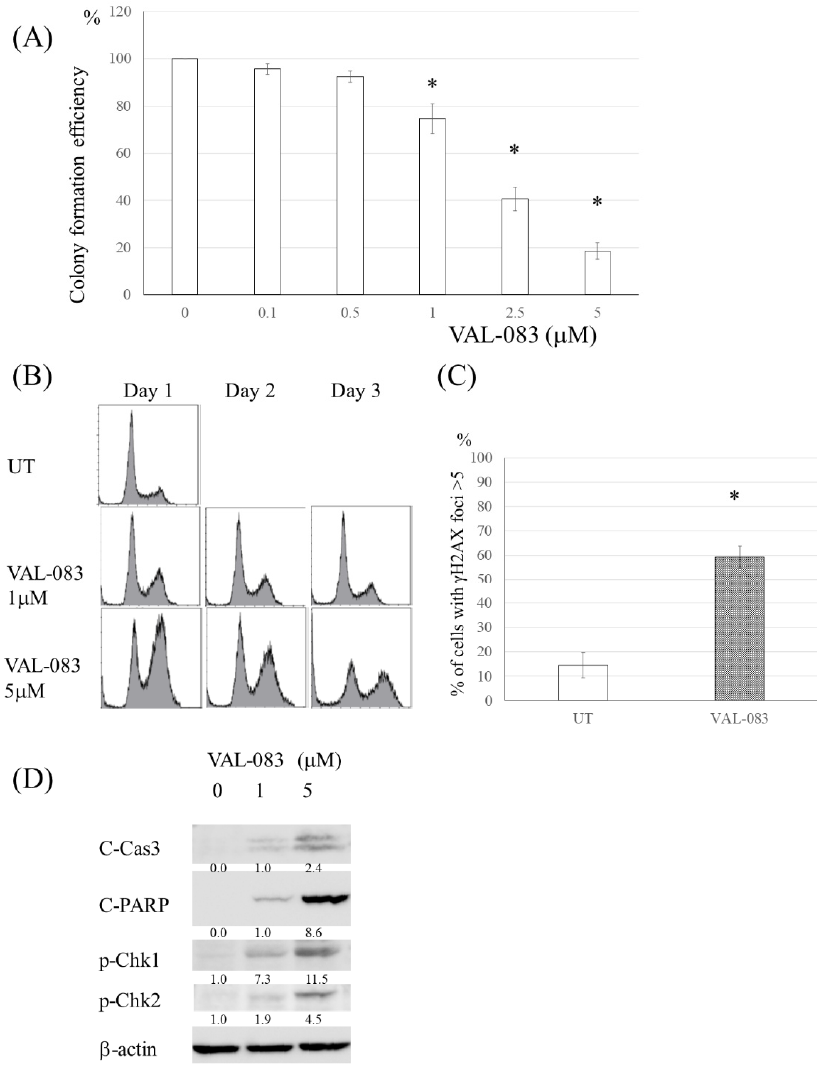
Figure 5. DAG induced cytotoxicity in TMZ-resistant glioma cells independent of MMR deficiency or MGMT expression. ( A ) Colony formation efficiency of U251TMZR#8 cells following VAL-083 exposure (0–5 µ M, 3 days). ( B ) Fluorescence- activated cell sorting analysis of cell cycle distribution in U251TMZR#8 after VAL-083 exposure. ( C ) Quantitative data from immunofluorescence analysis of γ -H2AX foci in U251TMZR#8 cells treated with VAL-083. ( D ) Western blot analysis of cleaved PARP, cleaved caspase 3, phosphor-chk1, phosphor-chk2, and β -actin levels inU251TMZR#8 cells treated with VAL-083. *, p <